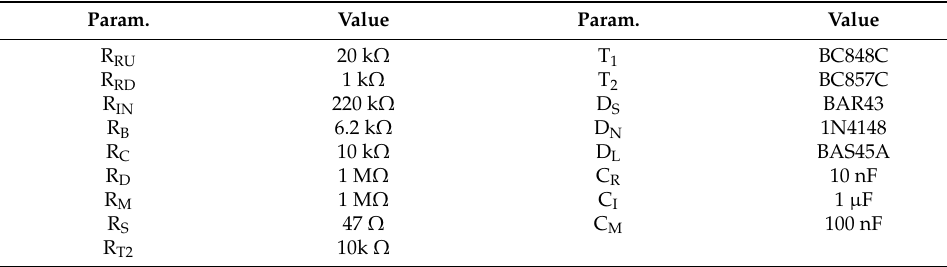
Table A2. Parameters for the SYN. Param. Value Param.